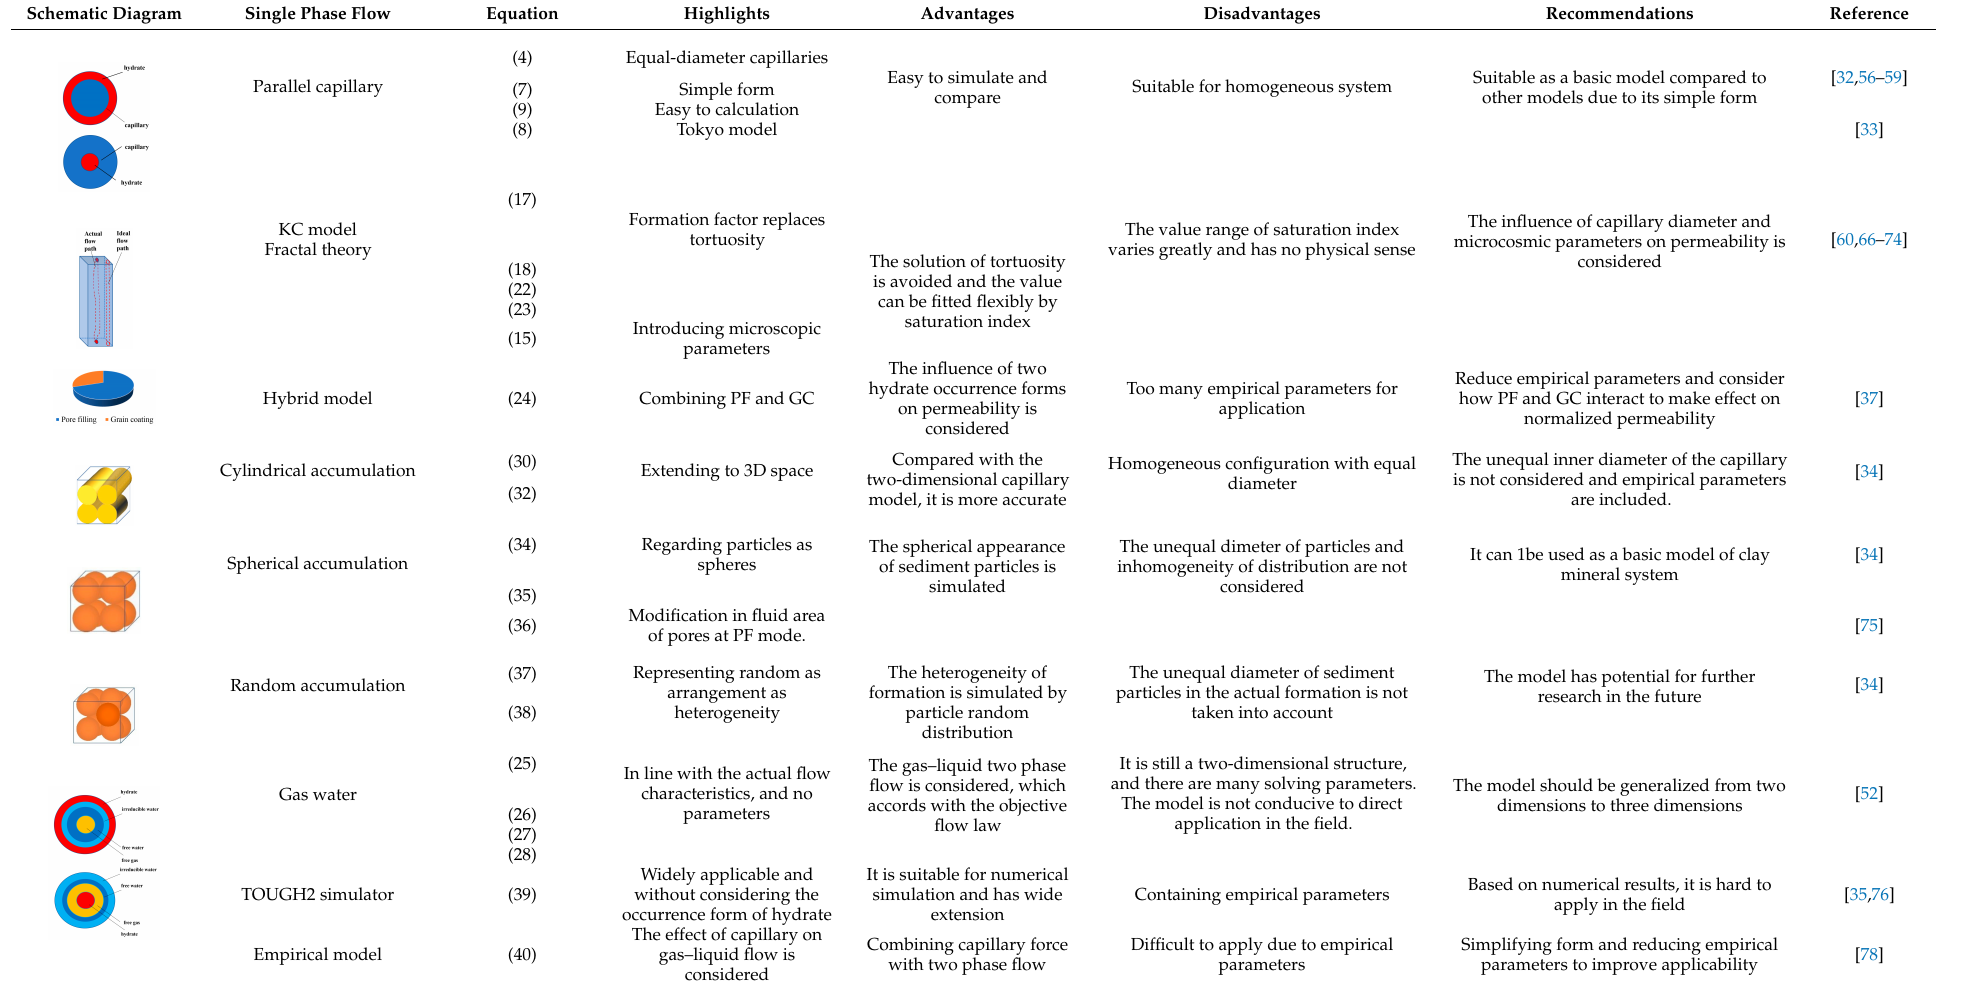
Table 2. Comparison of normalized permeability models of HBS and original permeability models of sediments without hydrate. Schematic